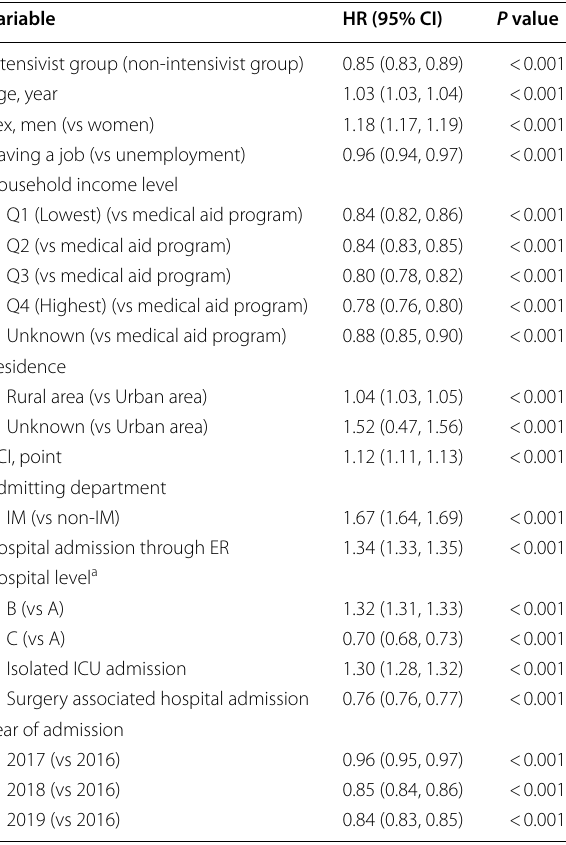
Table 3 Mixed effects Cox regression model for 1‑year